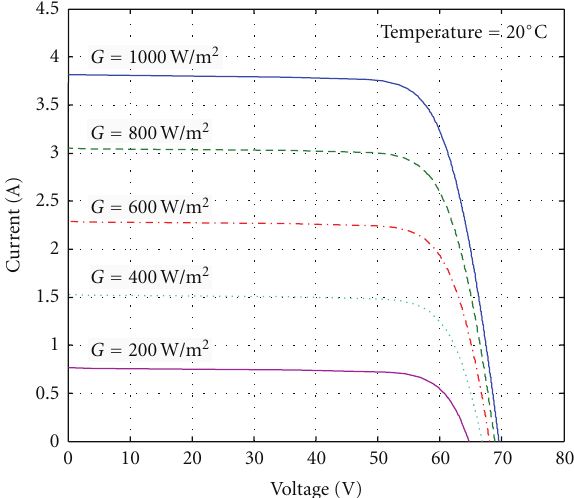
Figure 10: E ff ects of solar radiation at constant temperature on the PV module.